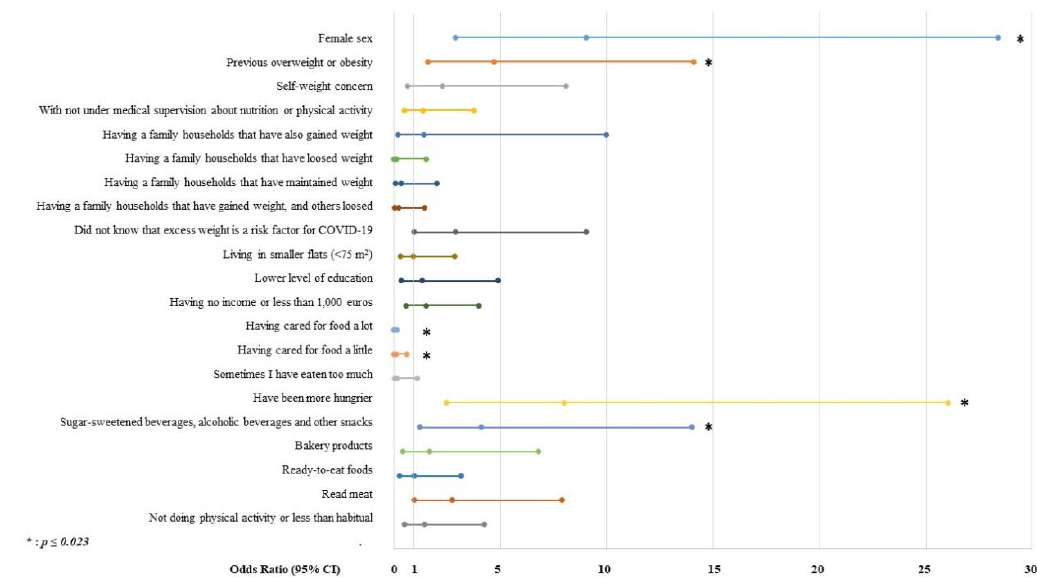
Figure 1. Multivariable logistic regression model for weight gain during the COVID-19 lockdown in Spain.